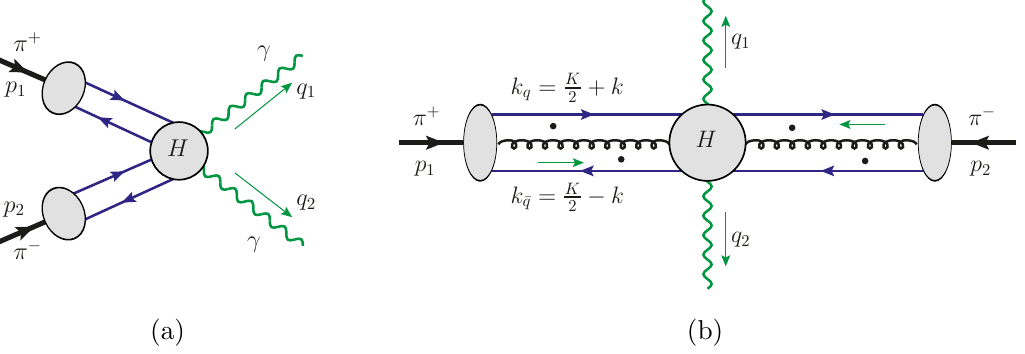
Figure 3. (a) Exclusive massive photon-pair production in π + π − annihilation, and (b) sample diagram to show the existence of perturbative pinch needed to separate the dynamics at different